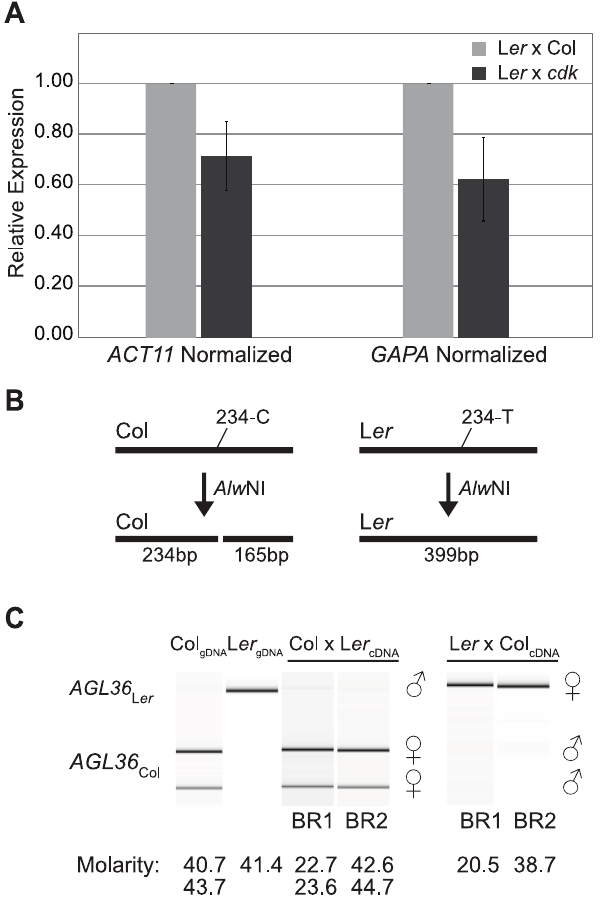
Figure 2. AGL36 is only expressed from the maternal genome. (A) Real-time PCR analysis showing AGL36 expression in L er x cdka;1 relative to L er x Col seeds 3 DAP. Gray bars represent L er x Col expression levels, black bars represent the L er x cdka;1 expression levels. Left section: AGL36 normalized to ACT11 levels. Right section: AGL36 normalized to GAPA levels. Average values from three independent biological replicas are shown. Error bars indicate standard deviation (STDEV). (B) Schematic overview of AGL36 SNP analysis. The presence of a SNP between Col and L er ecotypes (C-T conversion respectively) allows the amplified AGL36 cDNA PCR product from the Col ecotype to be digested with Alw NI restriction enzyme, while the L er ecotype remains undigested. (C) AGL36 is maternally expressed. Seeds obtained from Col x L er and L er x Col crosses were harvested at 3 DAP followed by AGL36 RT-PCR, Alw NI digestion and subsequent Bioanalyzer analysis. Genomic Col and L er were included as controls (Left section, first two lanes). Digestion products of two independent biological replicas of maternal Col x L er pollen crosses produced only Col bands, indicating maternal expression (Middle section). Similarly, the digestion products of two independent biological replicas of maternal L er x Col pollen produced only L er bands, indicating maternal expression (Left section). The intensities of the bands are represented as concentrations (nmol/L), and create a basis for comparison. 100 ng DNA was used as template for each PCR reaction. doi:10.1371/journal.pgen.1001303.g002 used in reciprocal crosses with wild-type L er and Col plants to examine GUS expression at 3 and 6 DAP. When inherited maternally, pAGL36::GUS expression in the seed was indeed found to be restricted only to the fertilization product (Figure 4B, Figure S7D). In the reciprocal cross, when pAGL36::GUS was inherited from the paternal genome, no GUS expression was detected, (Figure 4C, Figure S7E). Consistent with the SNP analysis, this